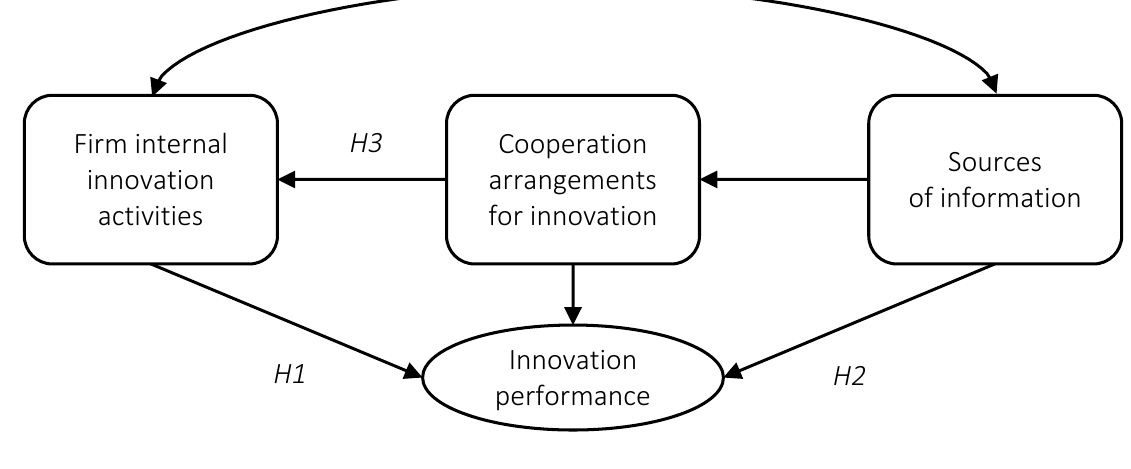
Figure 1. Research analytical